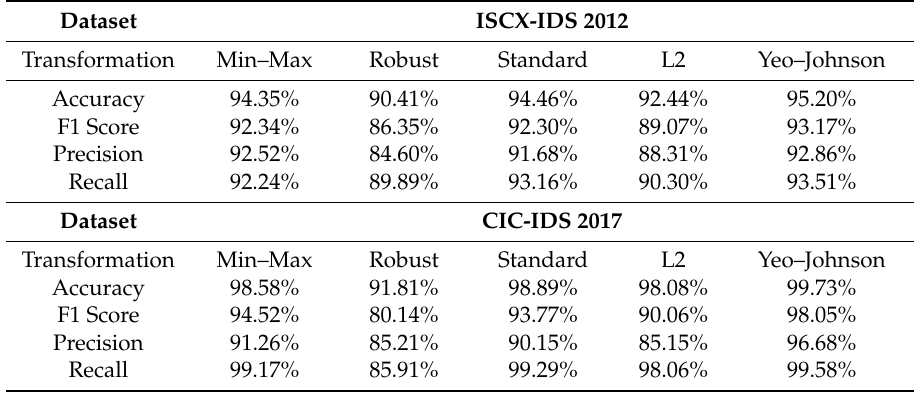
Table 3. Test results of the CIC-IDS 2017 and ISCX-IDS 2012 datasets based on